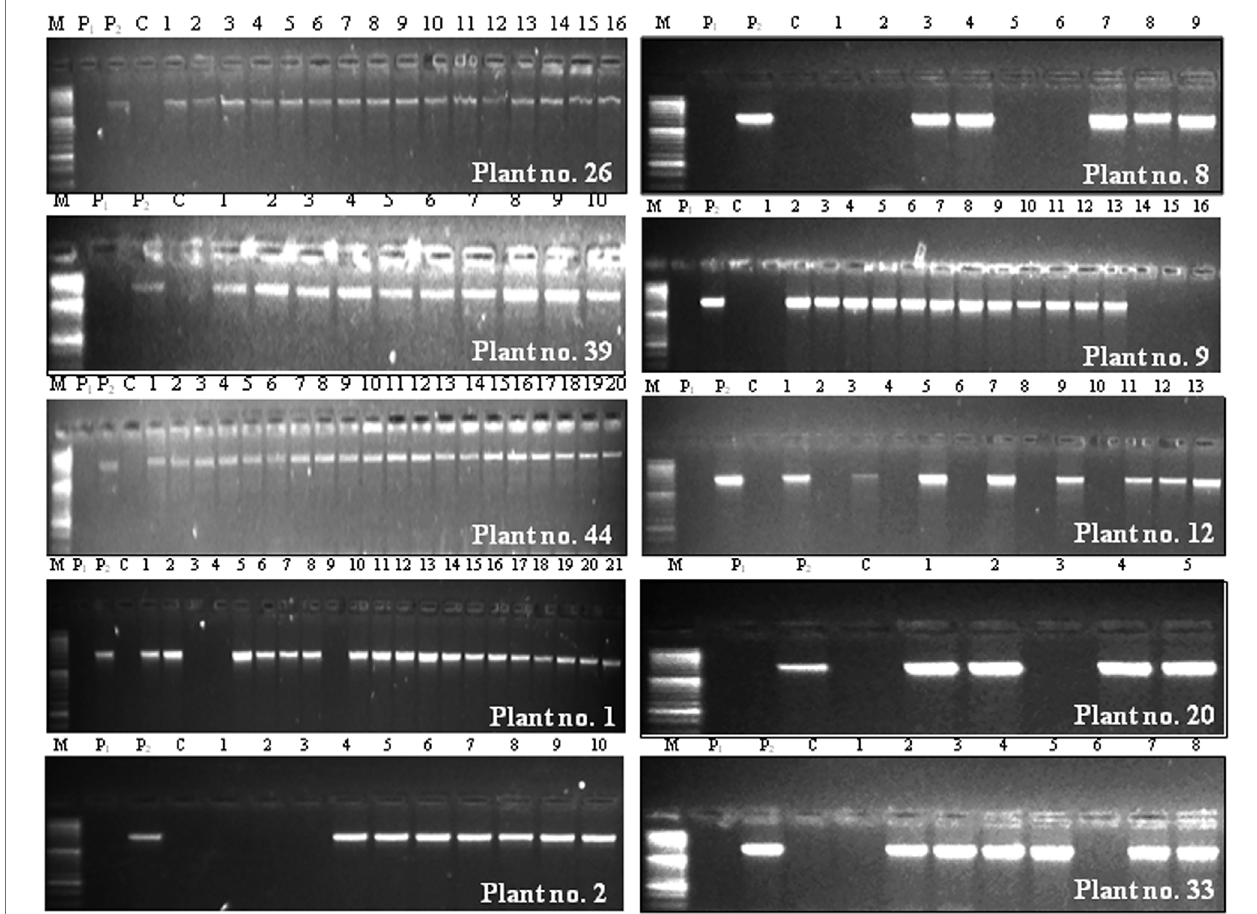
FIGURE 3 | Foreground selection of BC 2 F 3 population derived from Cross C (PBG7 × BS 100E) through PCR using cry1Ac-speci fi c primers. P 1 indicates non- transgenic recipient parent PBG7; P 2 representstransgenic donor parent BS 100E;Crefers tocontrolPCR reaction without template DNA; thenumbers ontop ofeach gel represent BC 2 F 3 progenies of a speci fi c plant, and its identity is mentioned in the right bottom corner of each gel; the plants designated as 26, 39, and 44 were homozygous for cry1Ac, and those designated as 1, 2, 8, 9, 12, 20, and 33 were hemizygous for the transgene; M represents 50 bp DNA ladder (Cat. No.